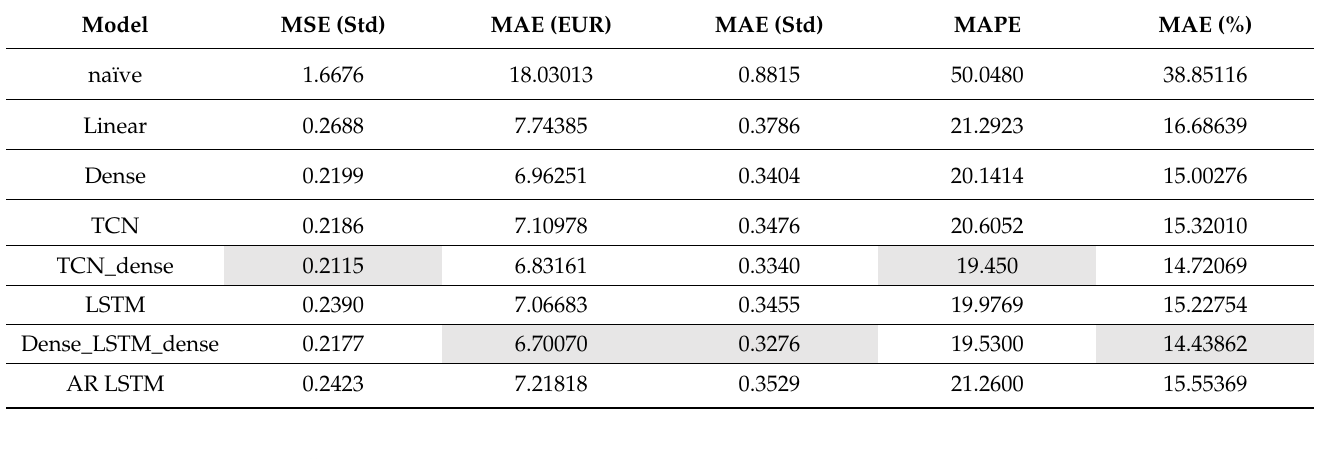
Table 3. Performance of models for electricity price prediction.